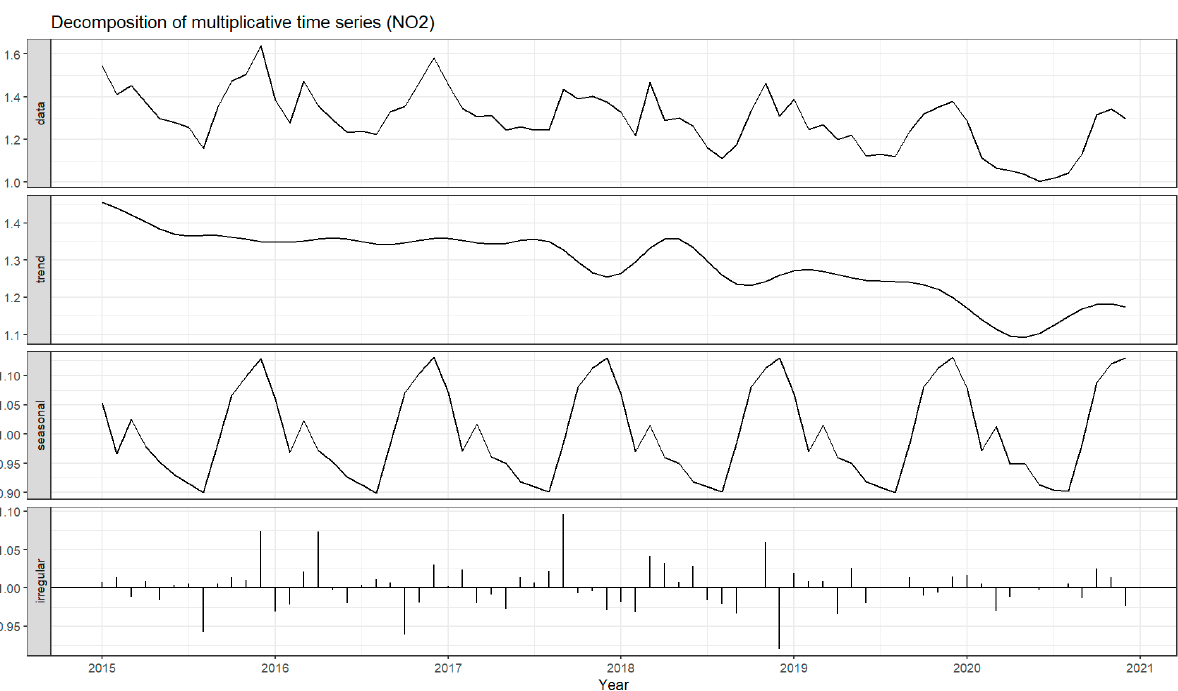
Figure 4. Decomposition of multiplicative time series of observed NO 2 data from 2015 to 2020 based on ground station data. The top graph is the original observed NO 2 data, consisting of trend, seasonal, and irregular components (the three bottom terms).